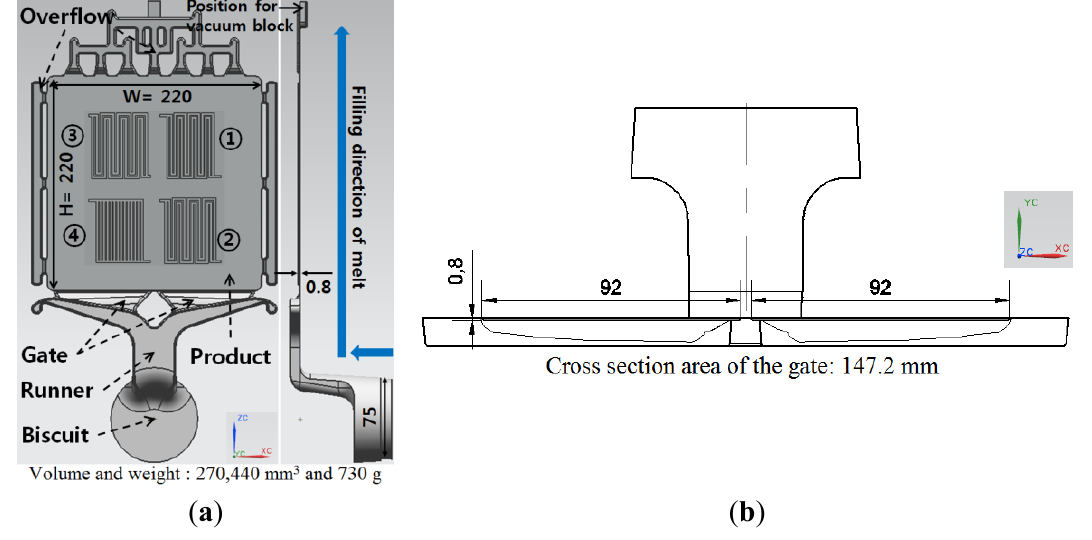
Figure 1. Geometry of die cavity with four mazes (unit: mm). ( a ) Geometry; ( b ) Gate.